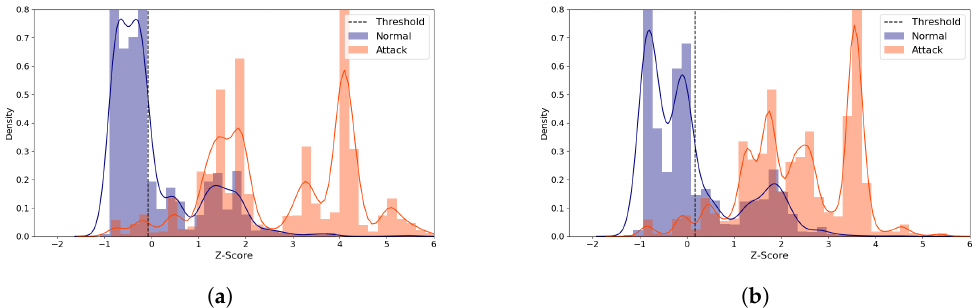
Figure 11. IoTID20 Reconstruction Distance Distribution Density Plot (Normal and attack data) comparing two similarly performing cases with the (5,64) model. Blue denotes the normal data and orange denotes the attack data. A line depicts the kernel density estimated plot, and bar plot depicts the histogram. The dotted line indicates the threshold value, which divides the normal and the attack classes. The X-axis denotes Z -score. The Y-axis is density and limited to 0.8 for better visibility. ( a ) The best case (Latent size = 28, MCC = 0.593, Threshold = 0.132). ( b ) A near-best case (Latent size = 9, MCC = 0.59, Threshold =